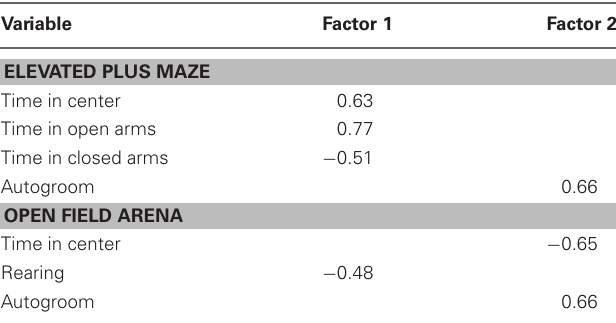
Table 4 | Factor loadings for extracted anxiety-like behavior